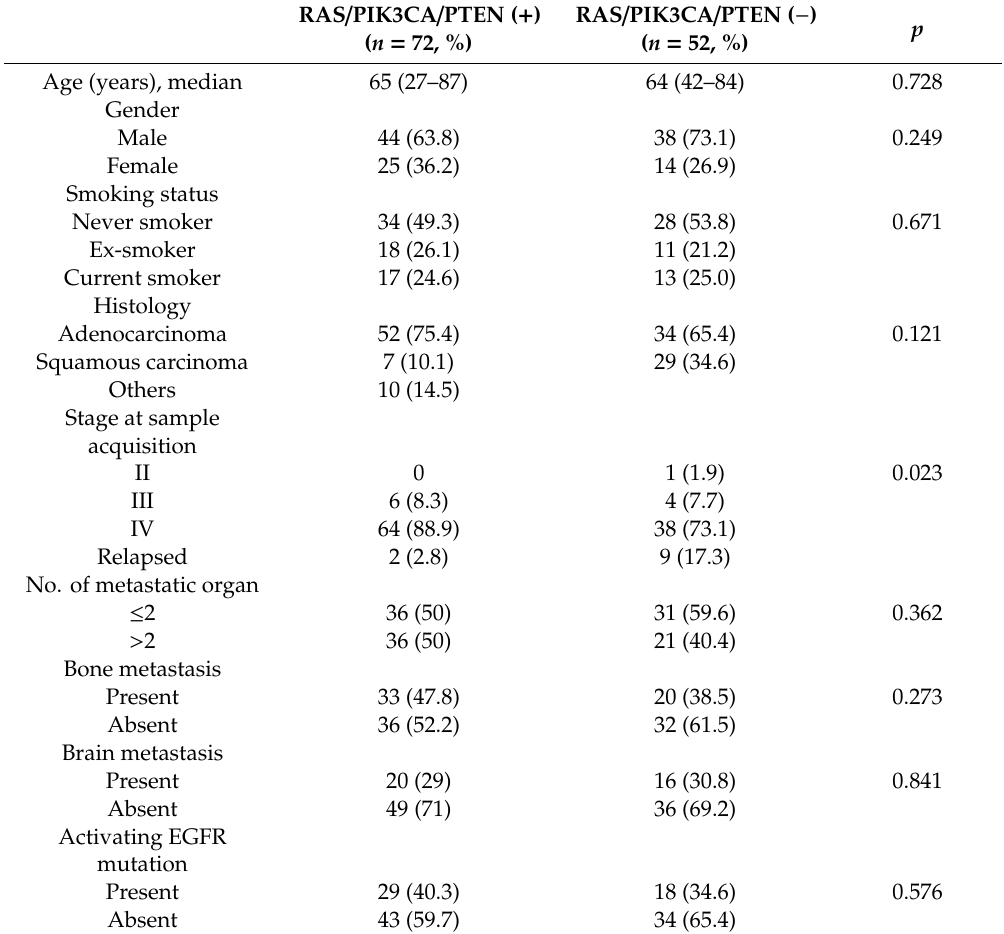
Table 3. Patients characteristic according to RAS / PIK3CA / PTEN mutations. RAS / PIK3CA / PTEN ( +